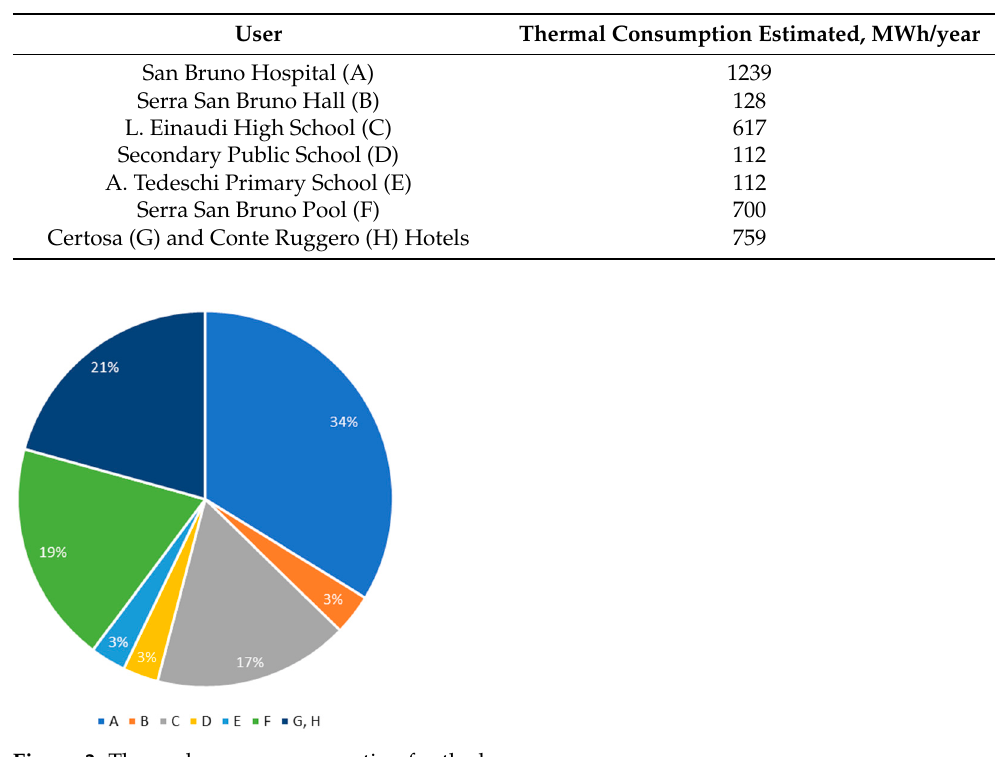
Figure 3. Thermal energy consumption for the large users.